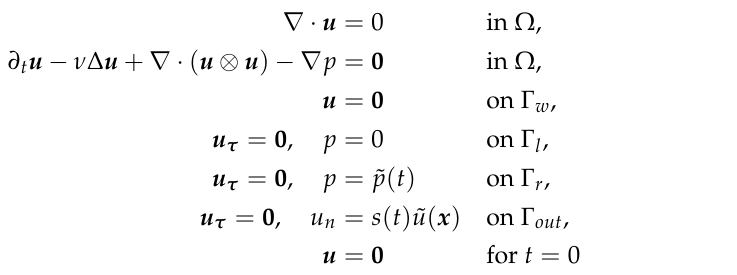
Figure 1. Geometry of the investigated micromixer. ( Left ): Below in the picture are the two inlets Γ l , Γ r and the T-junction. On the top, we find the outlet xy -plane on a grid with width 1